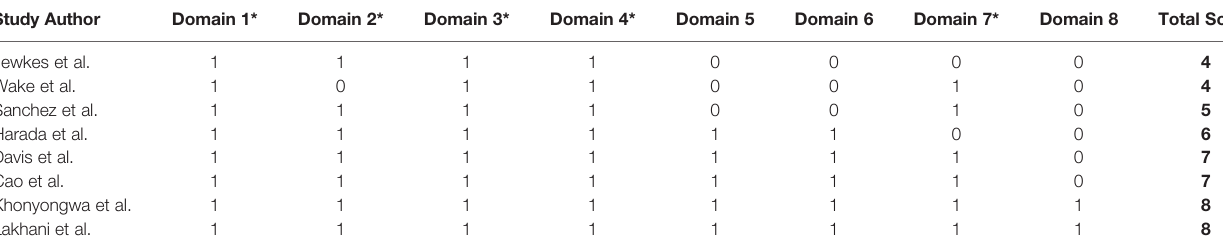
* Indicate core quality domains, as considered in sensitivity